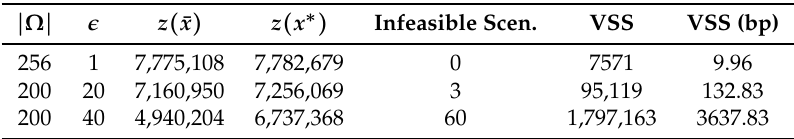
Table 3. Value of the stochastic